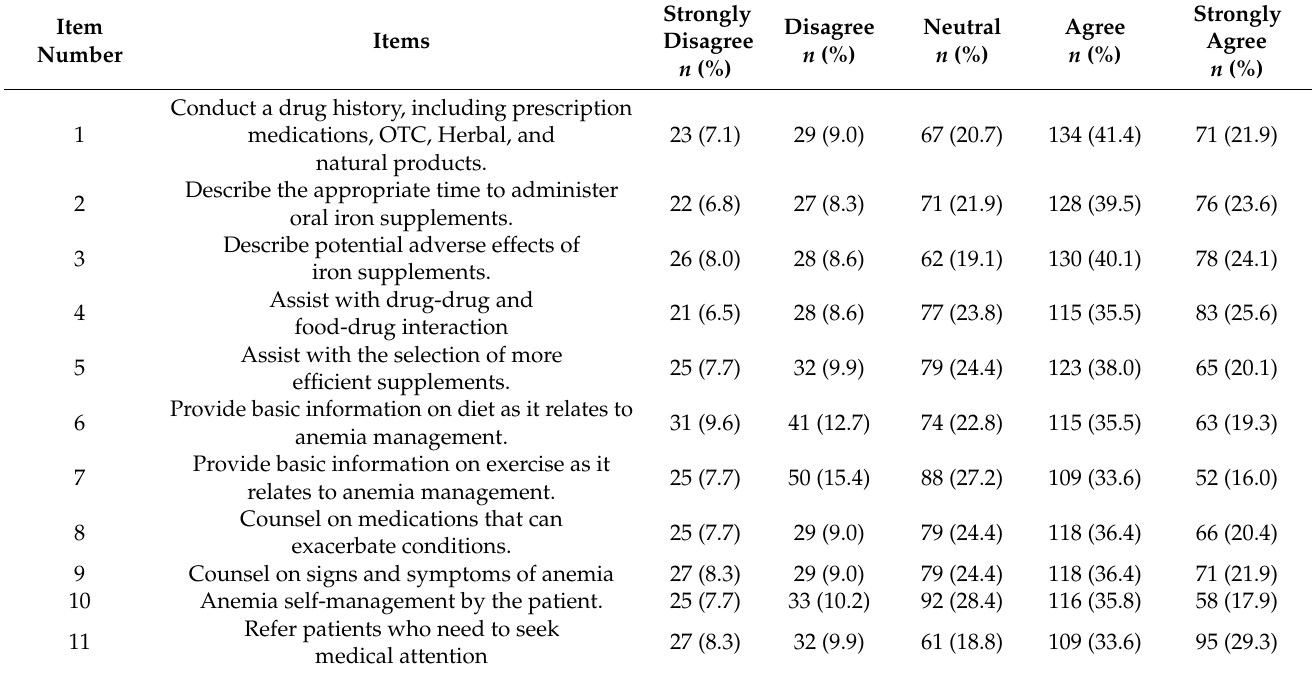
Table 3. Perceived roles of pharmacists in counseling patients with anemia.